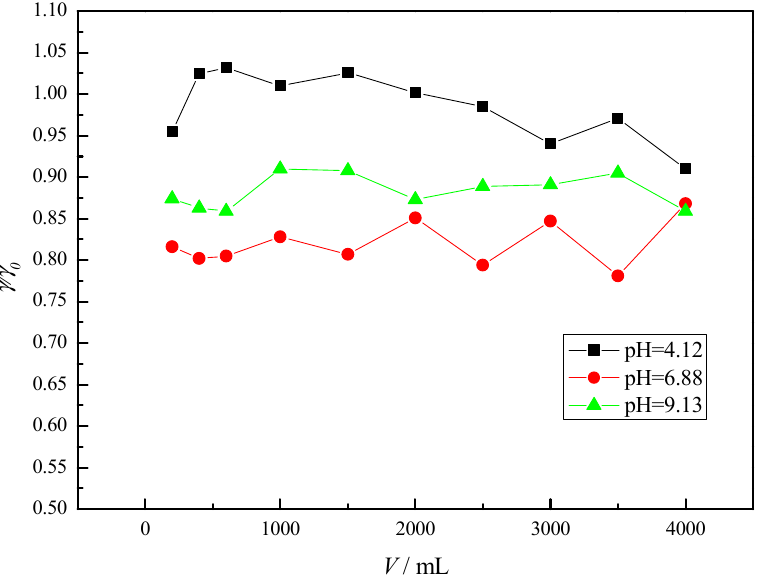
Figure 2. Breakthrough curves for mebendazole solutions at different pH-values.